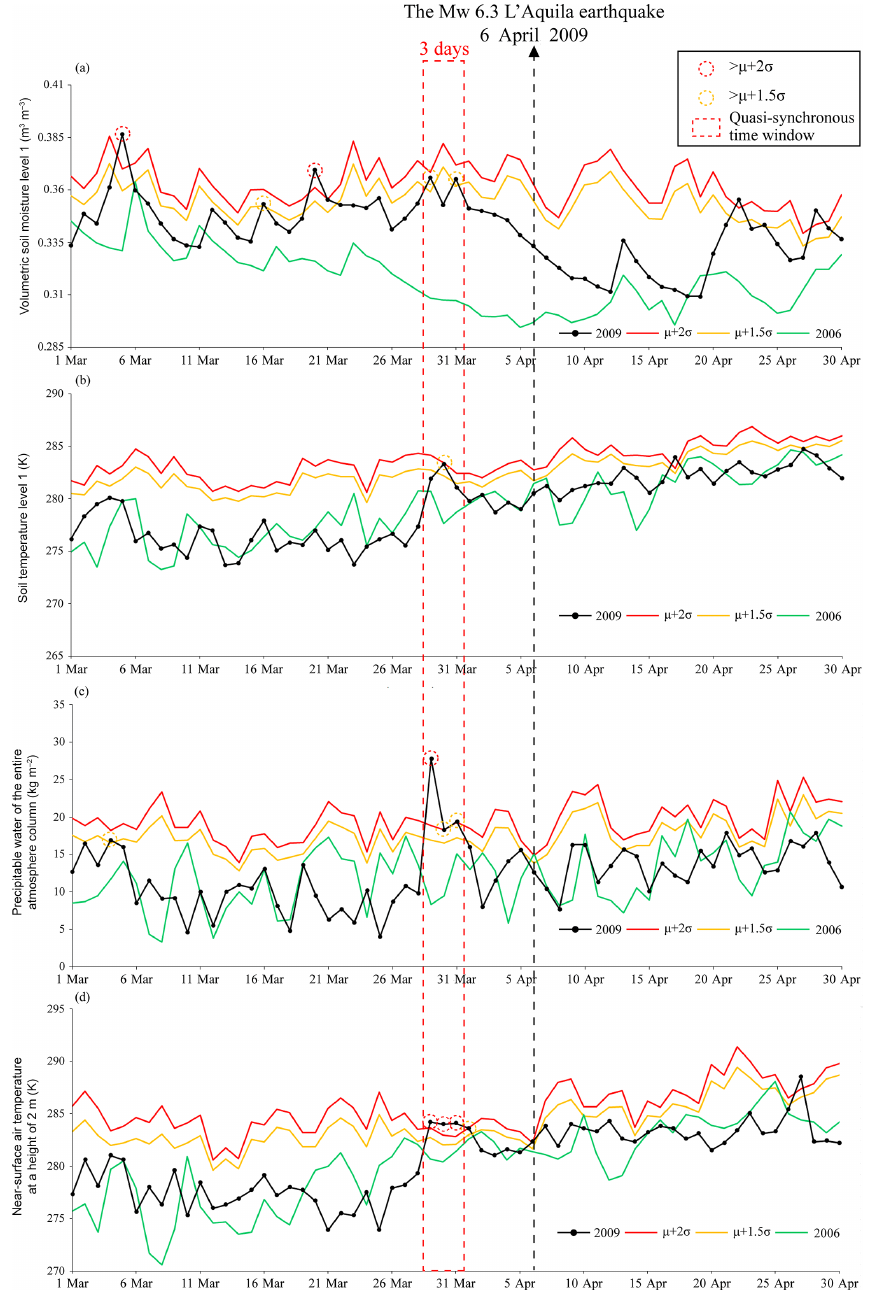
Figure 2. Time series of four hydrothermal parameters: volumetric soil moisture level 1 (a) , soil temperature level 1 (b) , precipitable water of the entire atmosphere column (c) , and near-surface air temperature at a height of 2m (d) , on the epicenter pixel from March to April 2009, and its comparison with historical data over the same period. The red and orange lines show the value of ( µ + 2 σ ) and ( µ + 1.5 σ ), respectively; the green and black lines show the value in 2006 (as a normal background) and 2009,